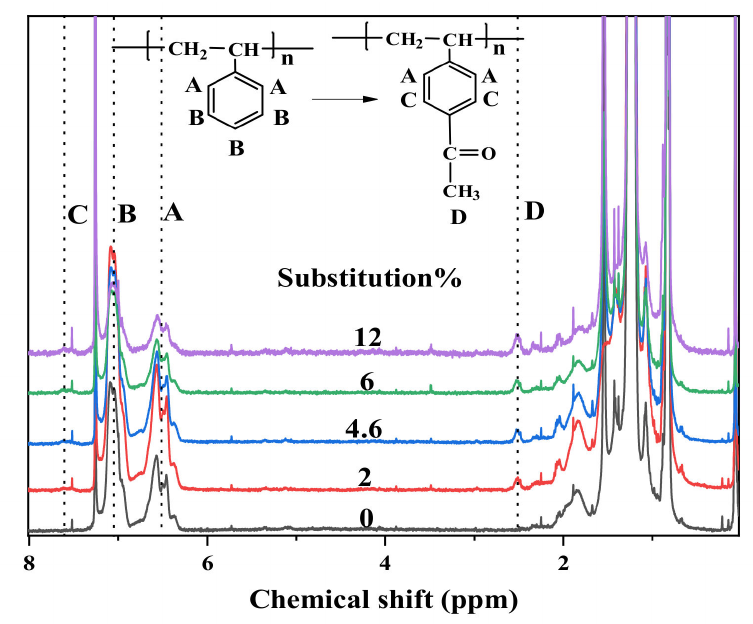
Figure 3. 1 H NMR spectra of SEBS and Ac-SEBS.